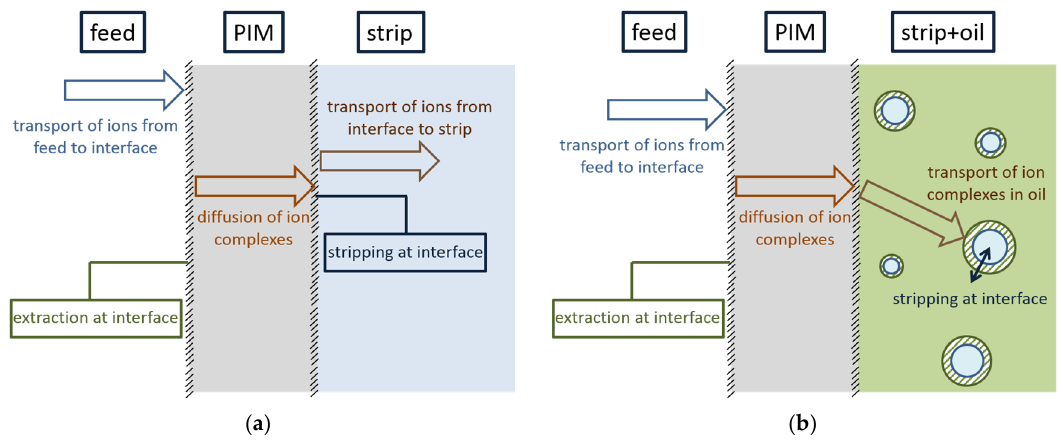
Figure 1. Schematic presentations of conventional PIM ( a ) and PIM with strip dispersion ( b ).